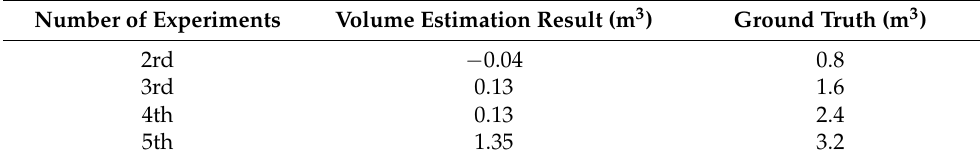
Table 2. Volume measurement result of